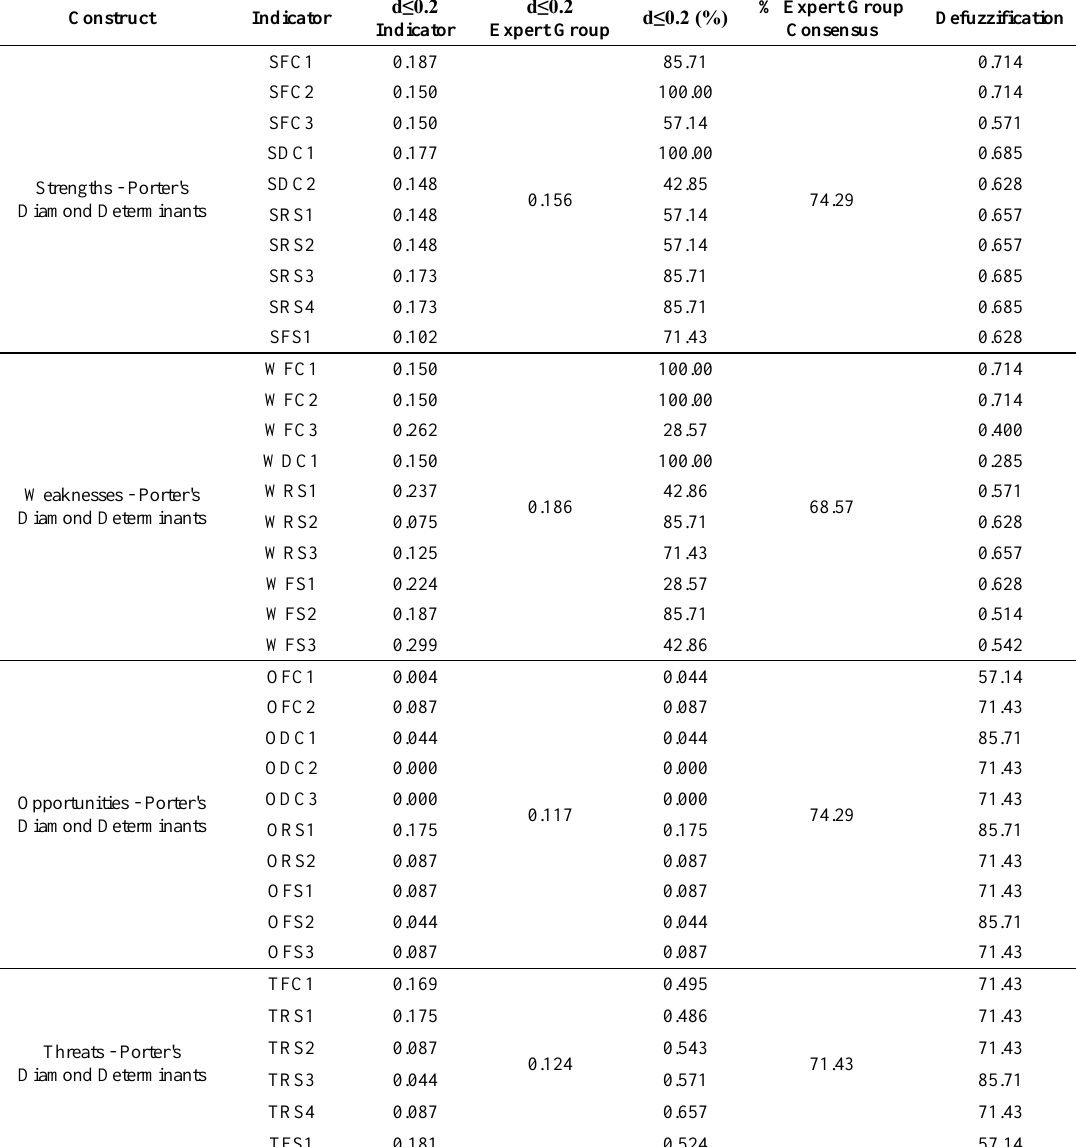
Table 9. Fuzzy Delphi Analysis for E-collaboration